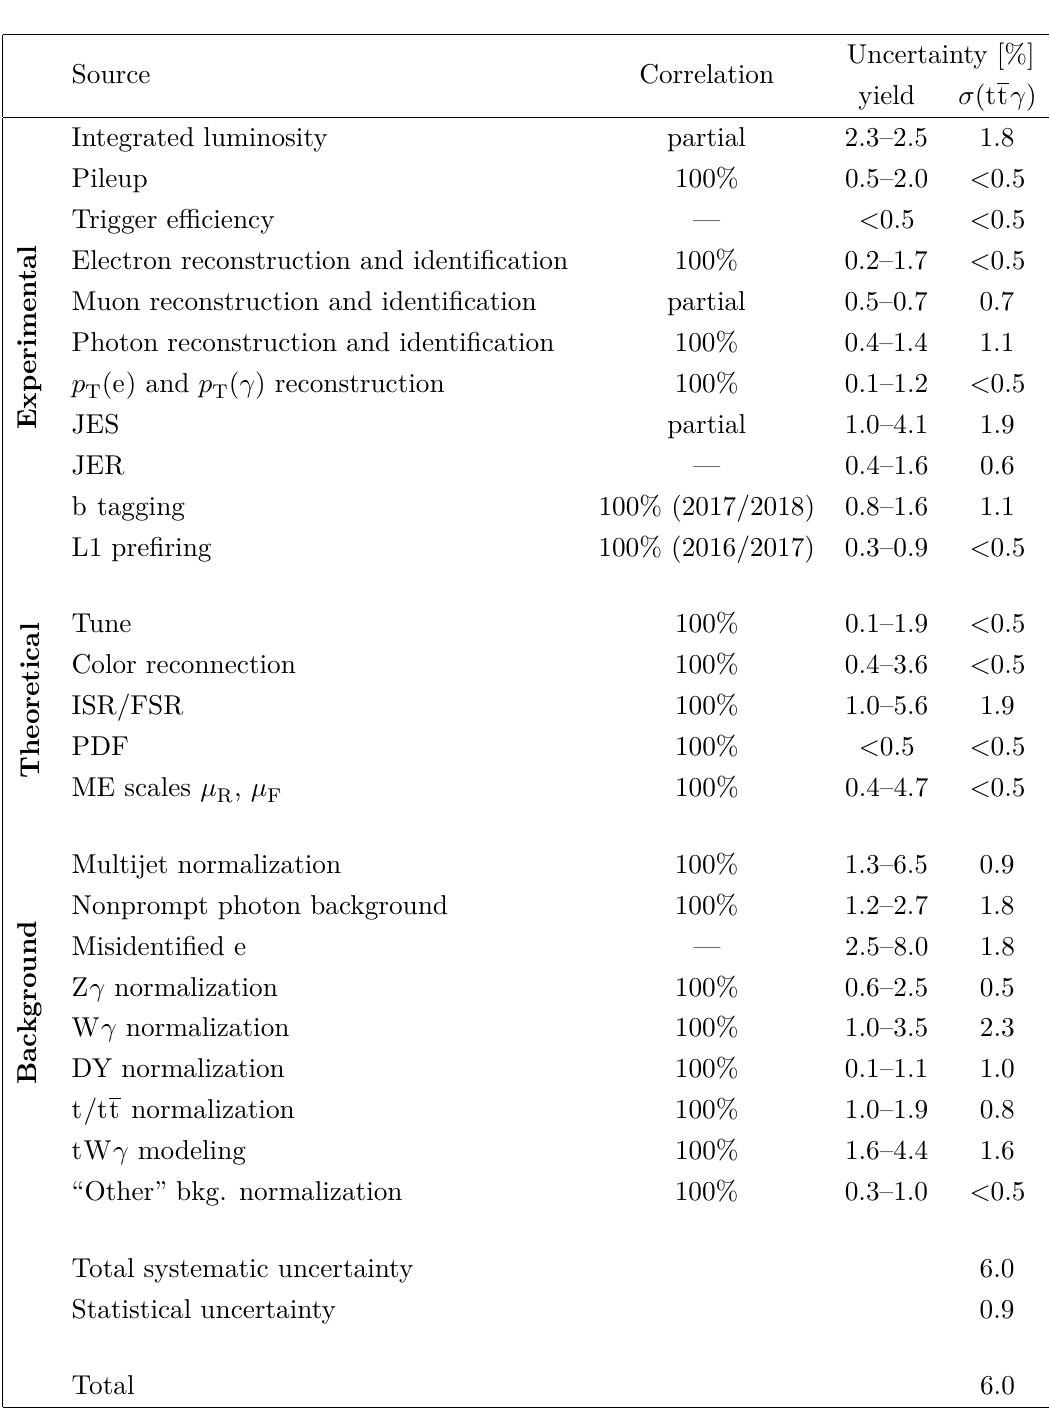
Table 5 . Breakdown of the total uncertainty in its statistical and systematic components in the different signal regions. The first column indicates the source of the uncertainty. The second column shows the correlation between the data-taking periods. The third column shows the typical pre-fit uncertainties in the total simulated yields in the signal region. The last column gives the corresponding systematic uncertainty in the tt γ cross section from the fit to the